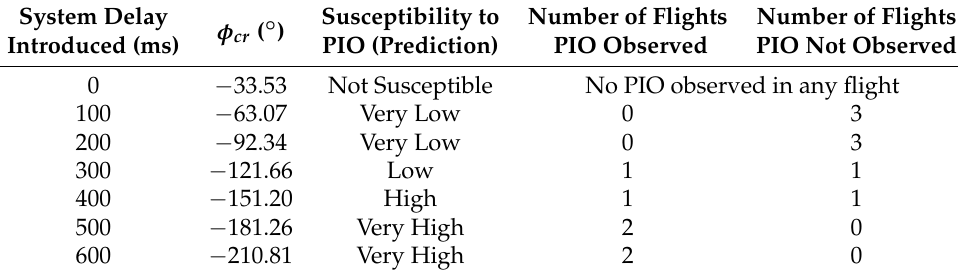
Table 2. Smith-Geddes criterion evaluation for “Phastball”